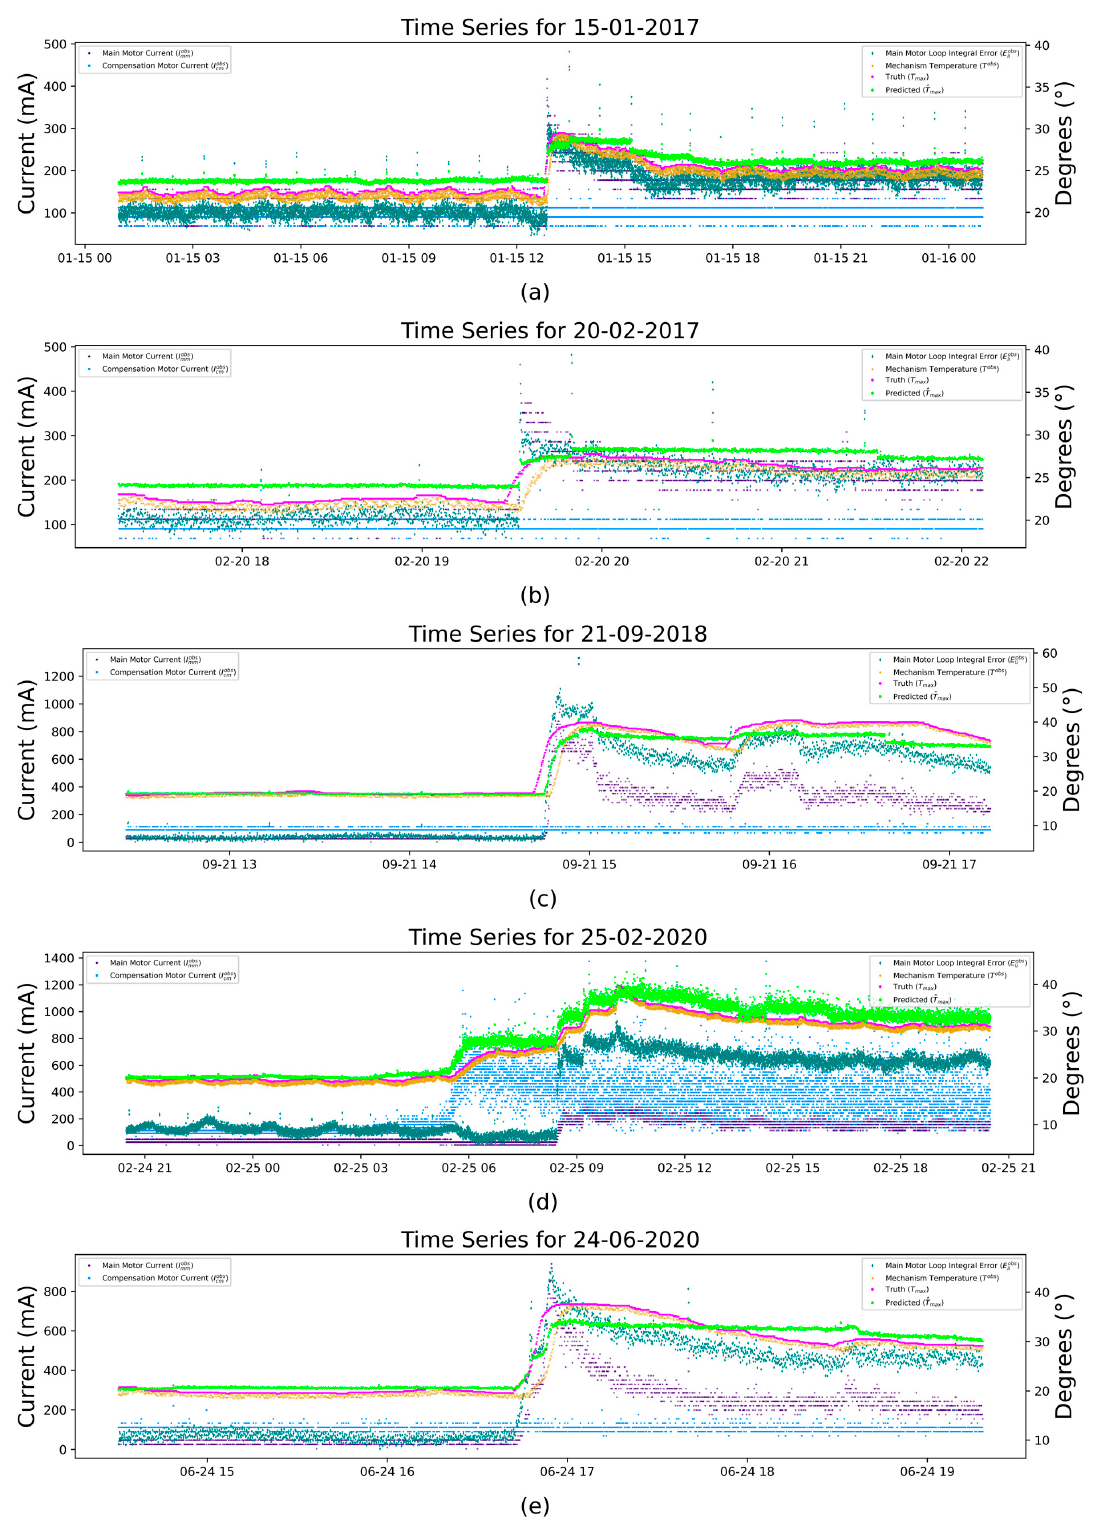
Figure 6. Time series showing the quality of the forecast for the temperature anomaly for five test cases that occurred on different dates: ( a ) 15-01-2017, ( b ) 20-02-2017, ( c ) 21-09-2018, and ( d ) 25-02-